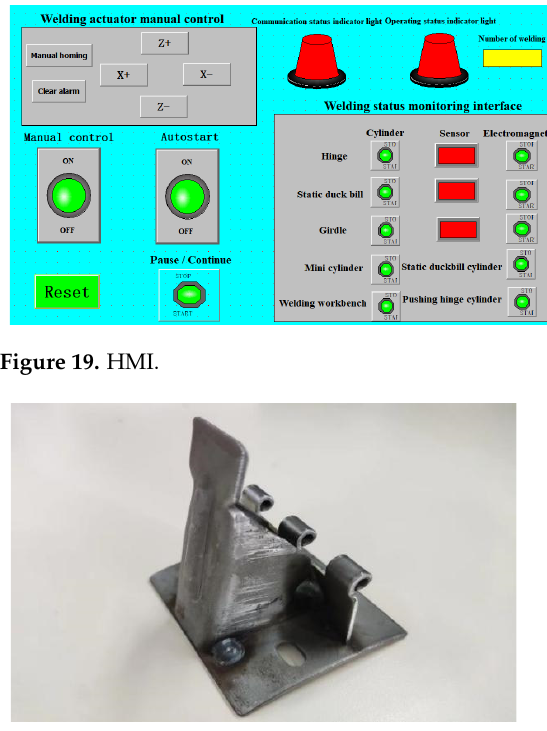
Figure 20. Welding forming of duckbill parts. Table 4. The cotton seeder duckbill welding robot performance comparison.